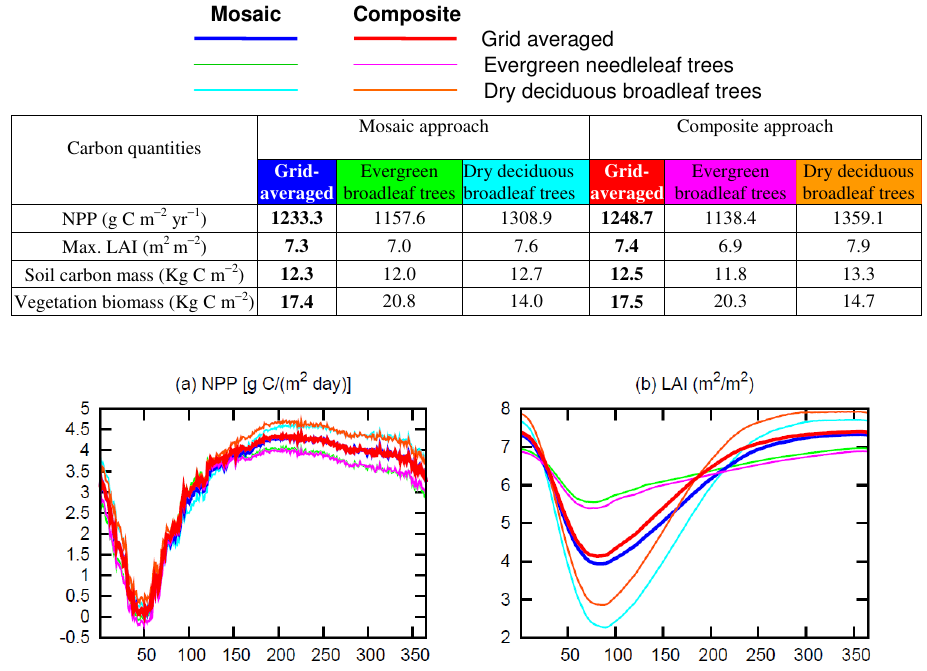
Fig. 8. Simulated daily averaged values of (a) NPP and (b) LAI for the Africa location for individual PFTs and grid-averaged values when using the two approaches. The table at the top summarizes the average annual values of NPP, vegetation biomass, soil carbon mass, and annual maximum values of LAI when using the two